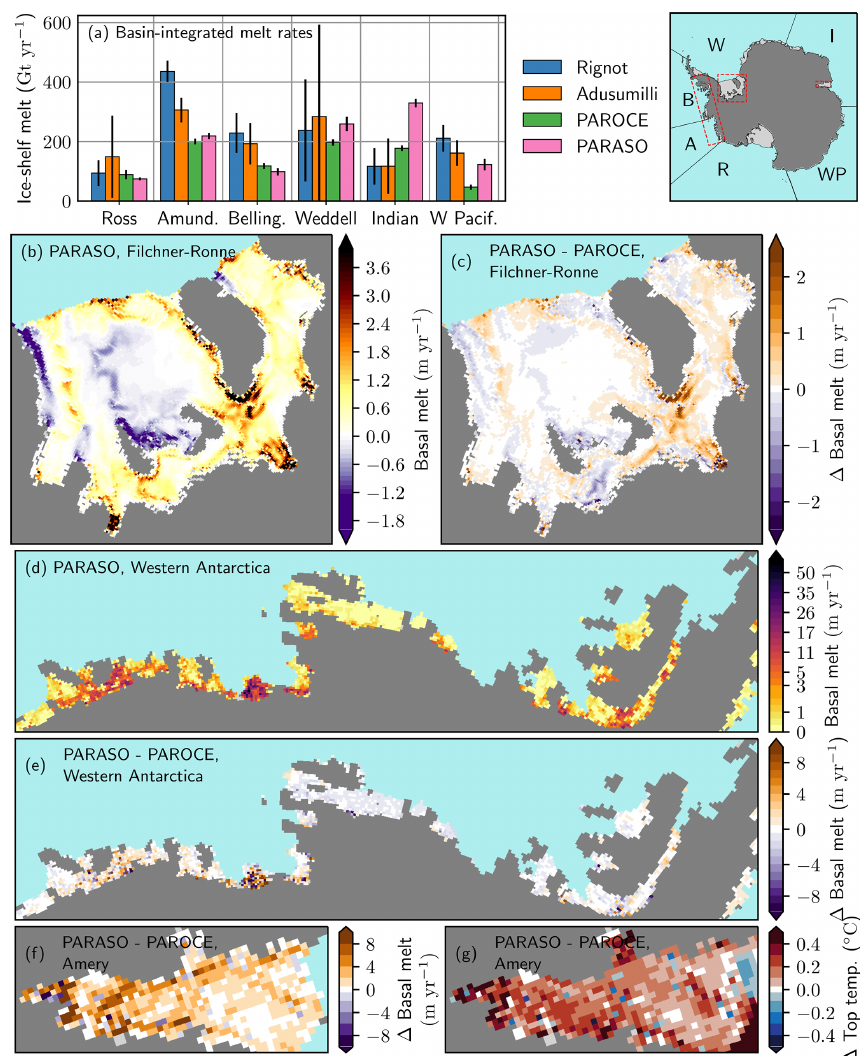
Figure 6. (a) Total ice-shelf melt rate over all sectors (see initials on indicative map) from observations (Rignot et al., 2013, and Adusumilli et al., 2020), PAROCE and PARASO. For observations, error bars correspond to measures uncertainties; for PAROCE and PARASO, to intra- annual STD. (b–c) Zoom-in on the Filchner–Ronne cavity for (b) PARASO (negative values indicate ice-shelf refreezing) and (c) PARASO– PAROCE differences (positive values indicate stronger PARASO melting). (d–e) Zoom-in for the western Antarctic sector for (d) PARASO (note the nonlinear color map scale) and (e) PARASO–PAROCE differences. (f–g) Zoom-in on the Amery Ice Shelf for (f) melt rate and (g) top conservative temperature PARASO–PAROCE differences. All simulation diagnostics are averaged over 2001 (second simulated